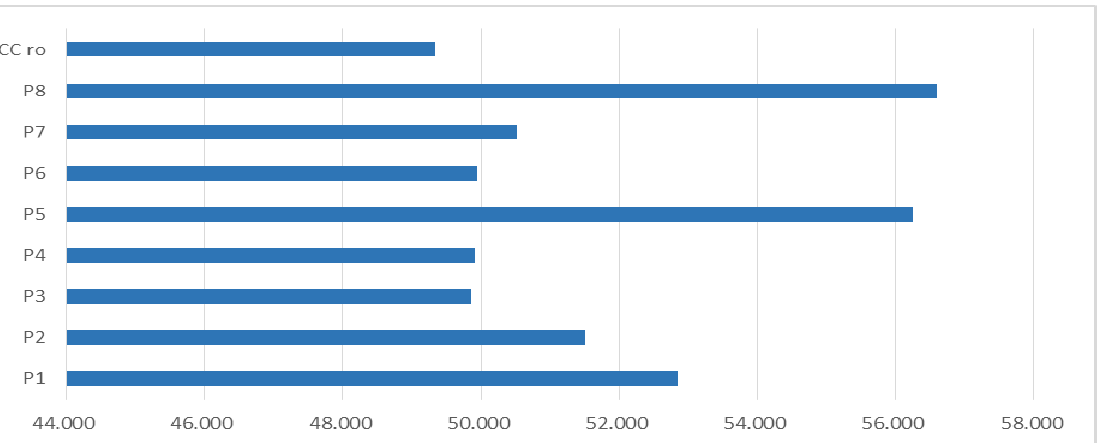
Figure 11. LCC at county level for the average scenario (bln.euro).